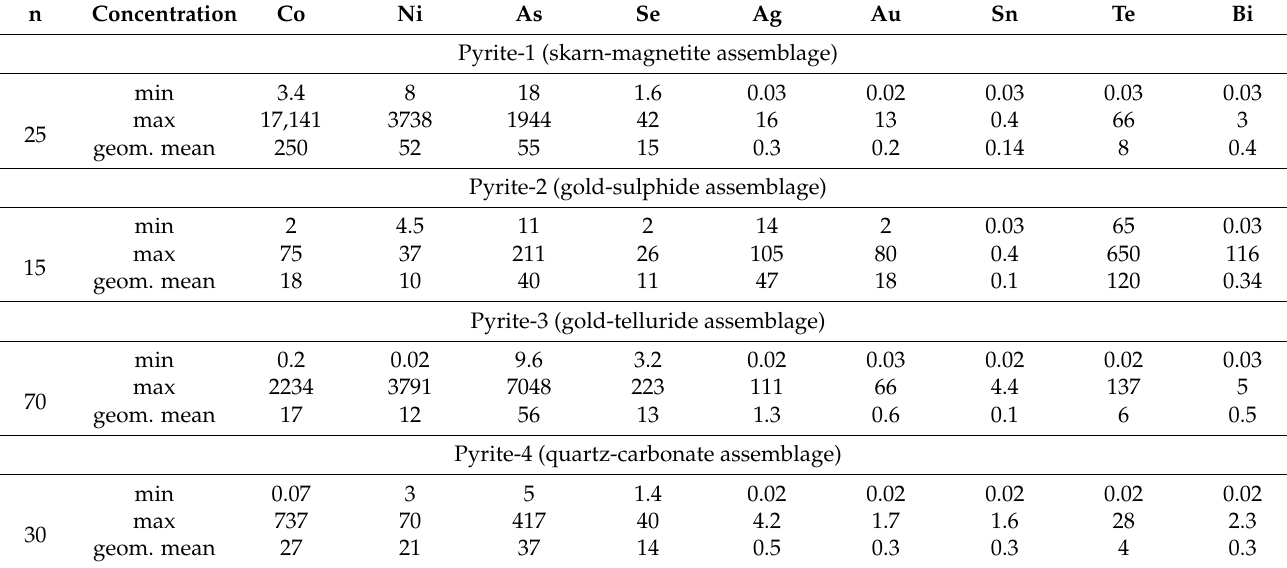
Table 7. Contents of trace elements in pyrite (ppm) of different assemblages of the Petropavlovsk gold-porphyry deposit according to LA-ICPMS data.